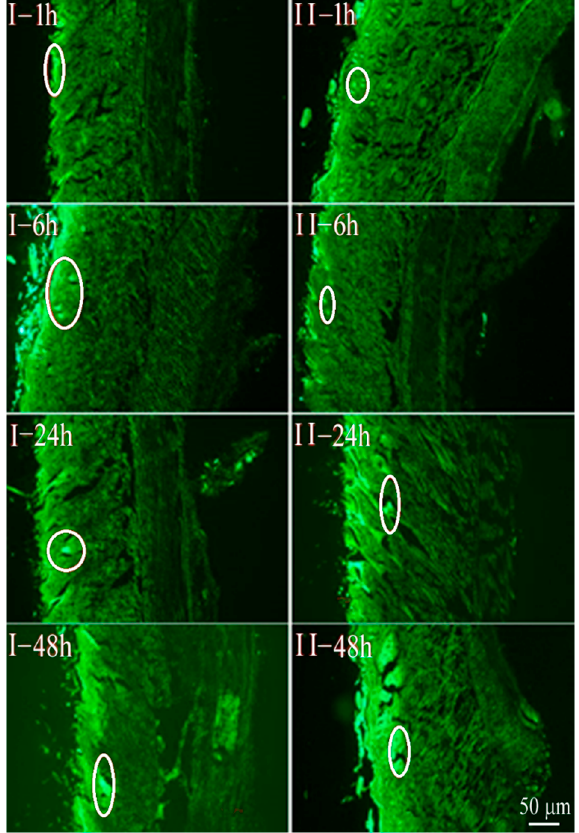
Figure 1. Fluorescence imaging of skin at different time after treated with dracorhodin perchlorate non-targeting emulsion gel ( left ) or dracorhodin perchlorate inflammation targeting emulsion gel ( right ). Scale bar is 50 μ m.